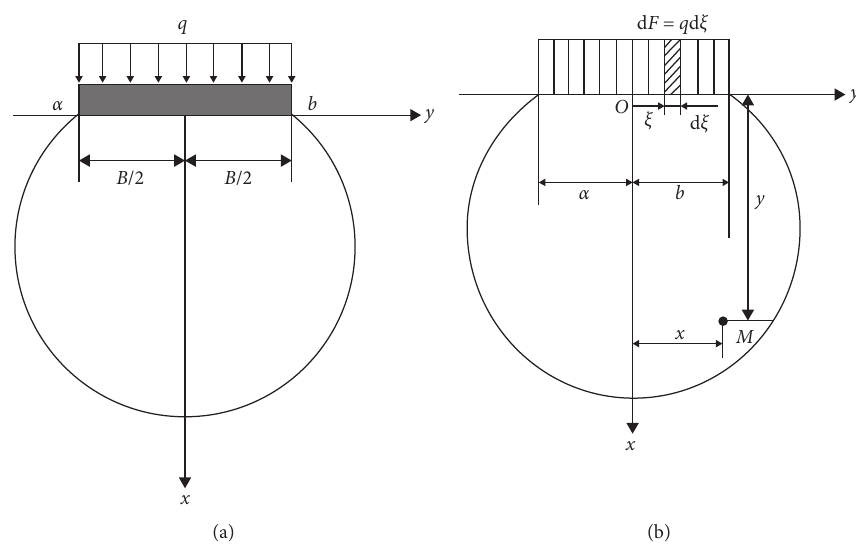
Figure 2: Mechanical model of strip coal